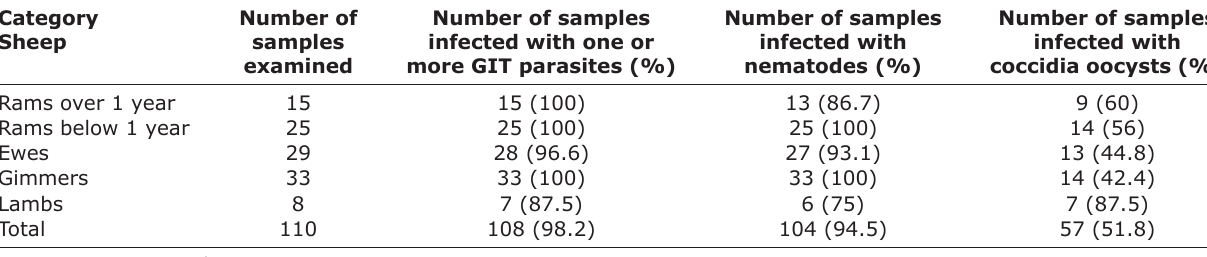
Table-2: Prevalence of gastrointestinal parasites of sheep in Ayeduase. Category